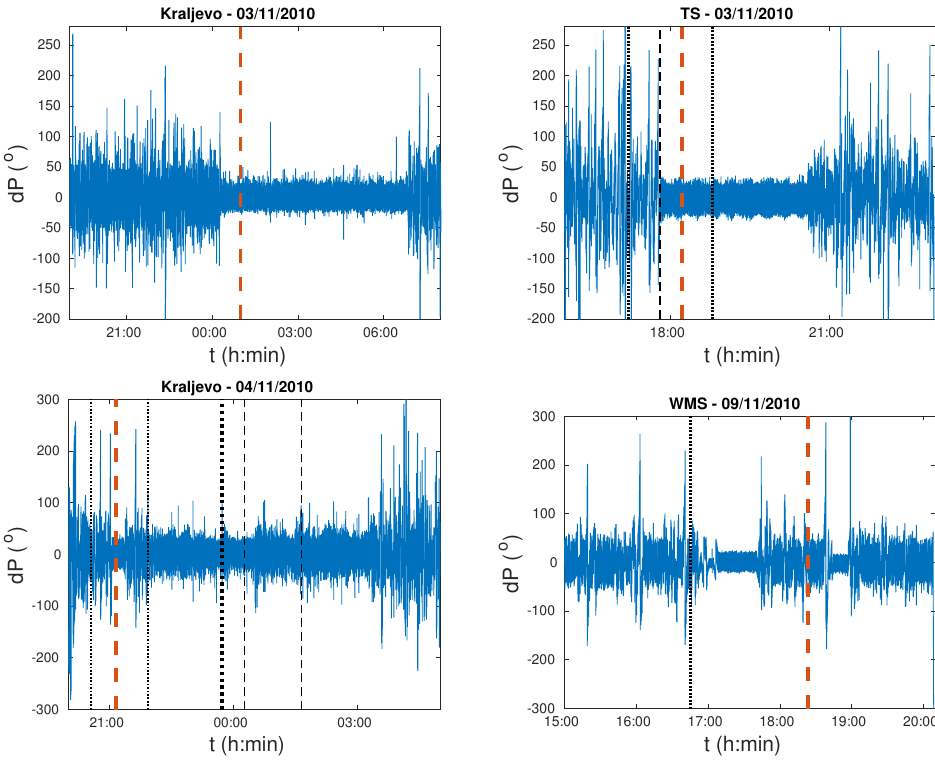
Figure 3. The same as in Figure 2 but for phase deviation dP = P data − P base .